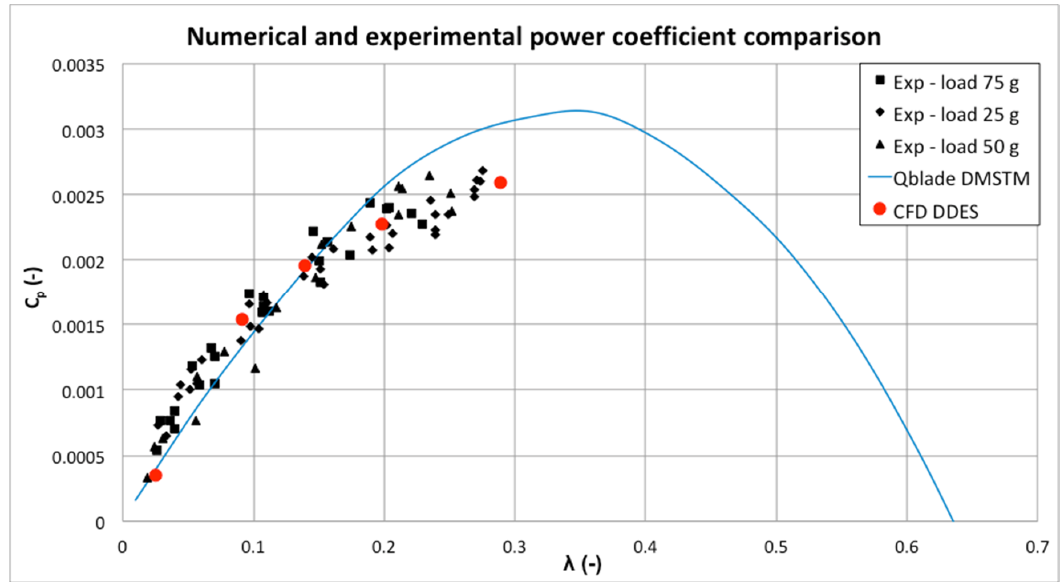
Figure 6. Comparison between numerical and experimental power coefficient.